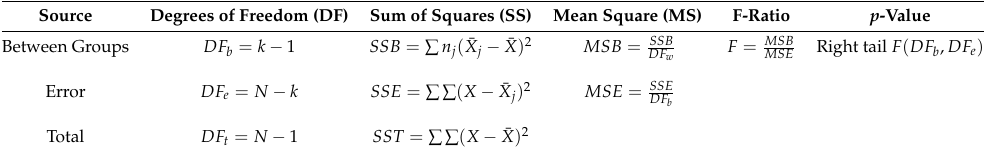
Table 1. One way ANOVA source table, courtesy of [37], where: X = individual observation, ¯ X th group, ¯ X = overall sample mean, k = number of groups, N = number j = sample mean of j of observations per